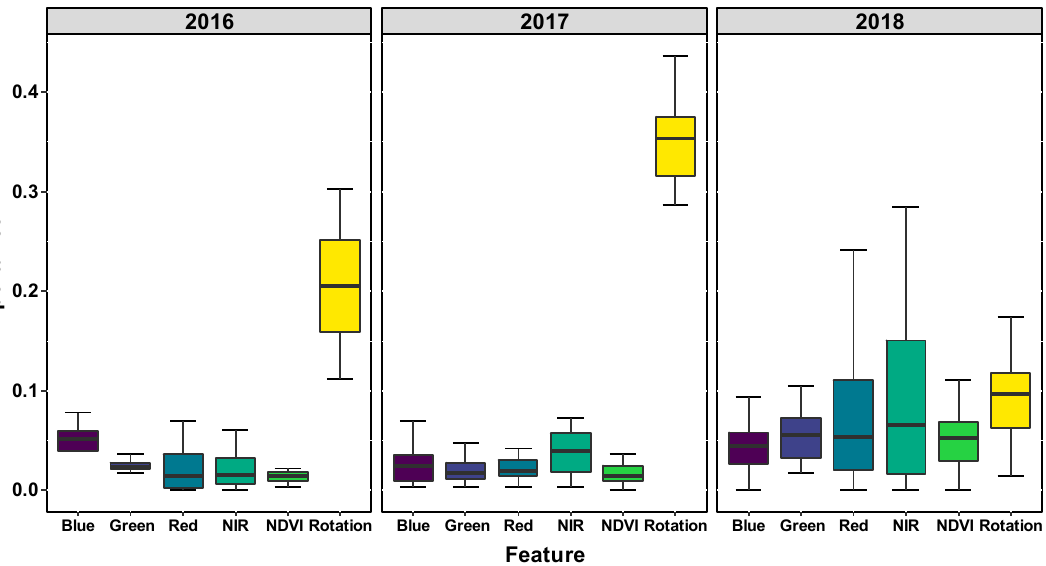
Figure 6. Distribution of predictive importance of features (B, G, R, and NIR image data from PlanetScope ortho scenes; NDVI; and crop rotation information) used to detect healthy and SDS-infected soybean quadrats in 2016, 2017, and 2018 crop growing seasons.